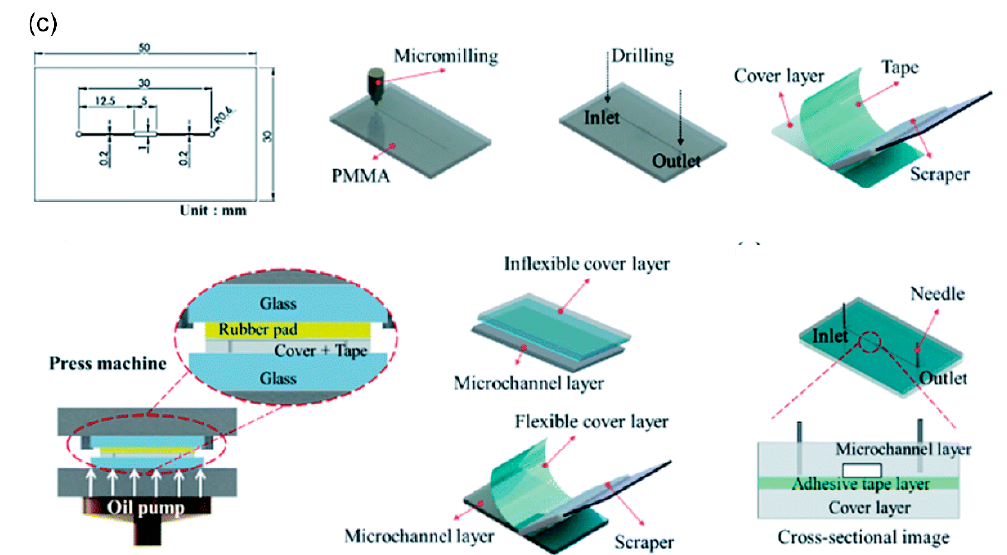
Figure 4. ( a ) Schematics showing the representative procedures for adhesive bonding using a dry adhesive film for fabricating thermoplastic microdevices. ( b ) Schematic illustration of the overall procedure for bonding PMMA device using PAA assisted by UV, the photograph of a clog-free PMMA microdevice including a serpentine microchannel with various channel dimensions. Adapted with permission from Ref. [77]. Copyright 2021, Elsevier. ( c ) Schematics showing the procedures of PMMA microdevice fabrication using an adhesive tape and press machine for bonding microdevice. Adapted with permission from Ref. [80]. Copyright 2020, Royal Society of